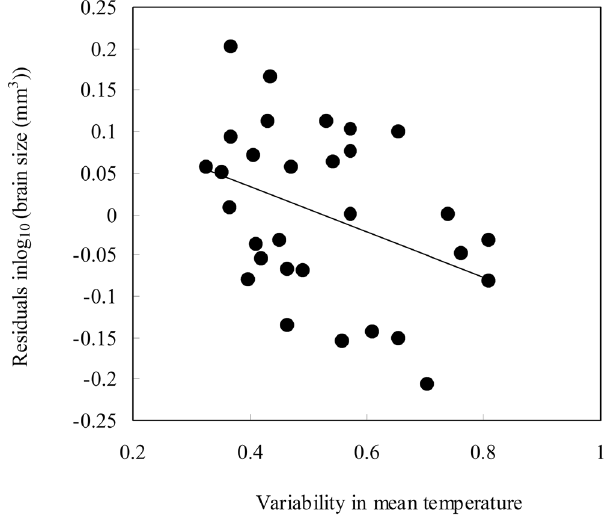
Figure 1. Relationship between relative brain size and variability in mean temperature across 30 anurans species.